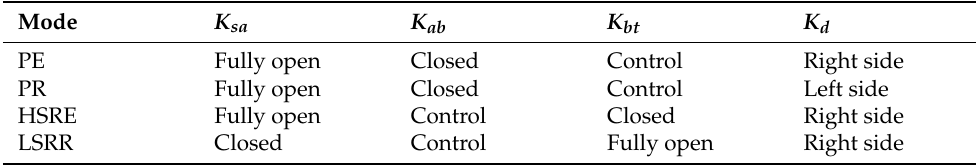
Table 1. The conductivity of valves on four metering